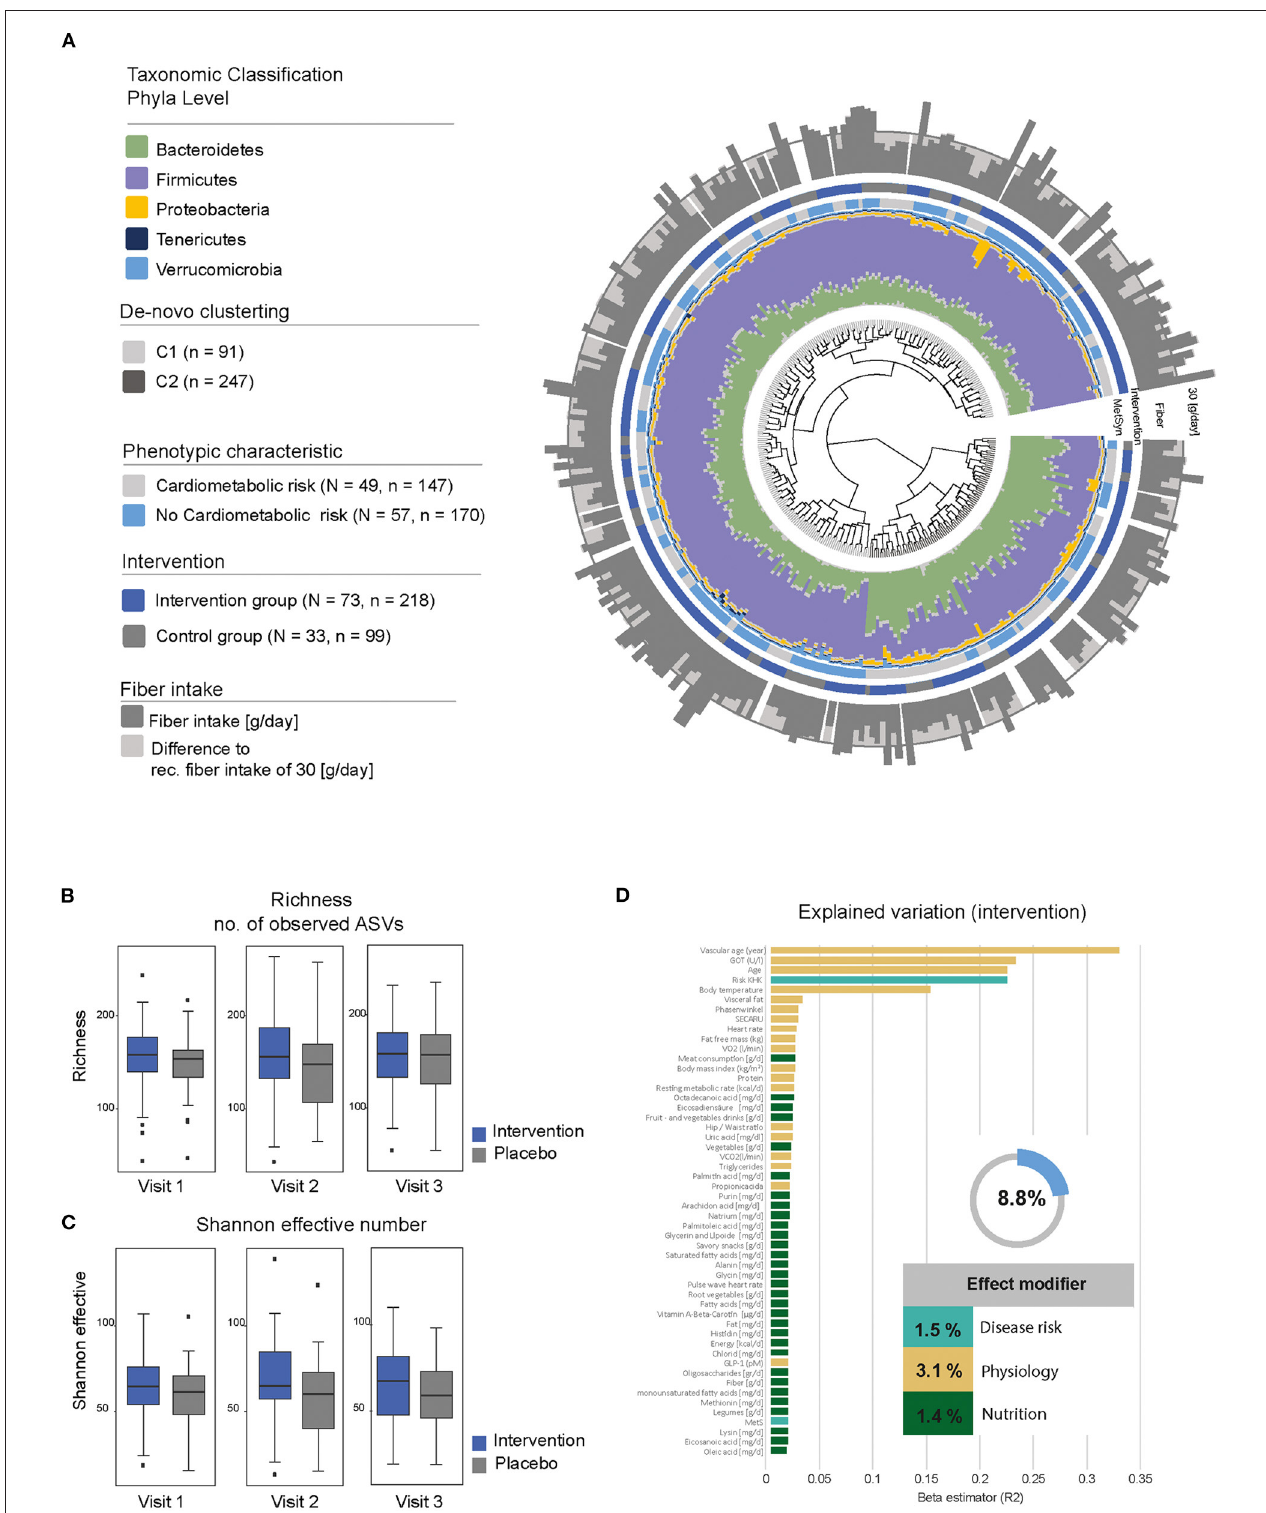
FIGURE 4 | Description of the gut microbial composition. (A) Beta-diversity of the fecal microbiota in enable. The dendrogram shows similarities between microbiota profiles based on generalized UniFrac distances between subjects represented by individual branches. Unsupervised hierarchical clustering identified two